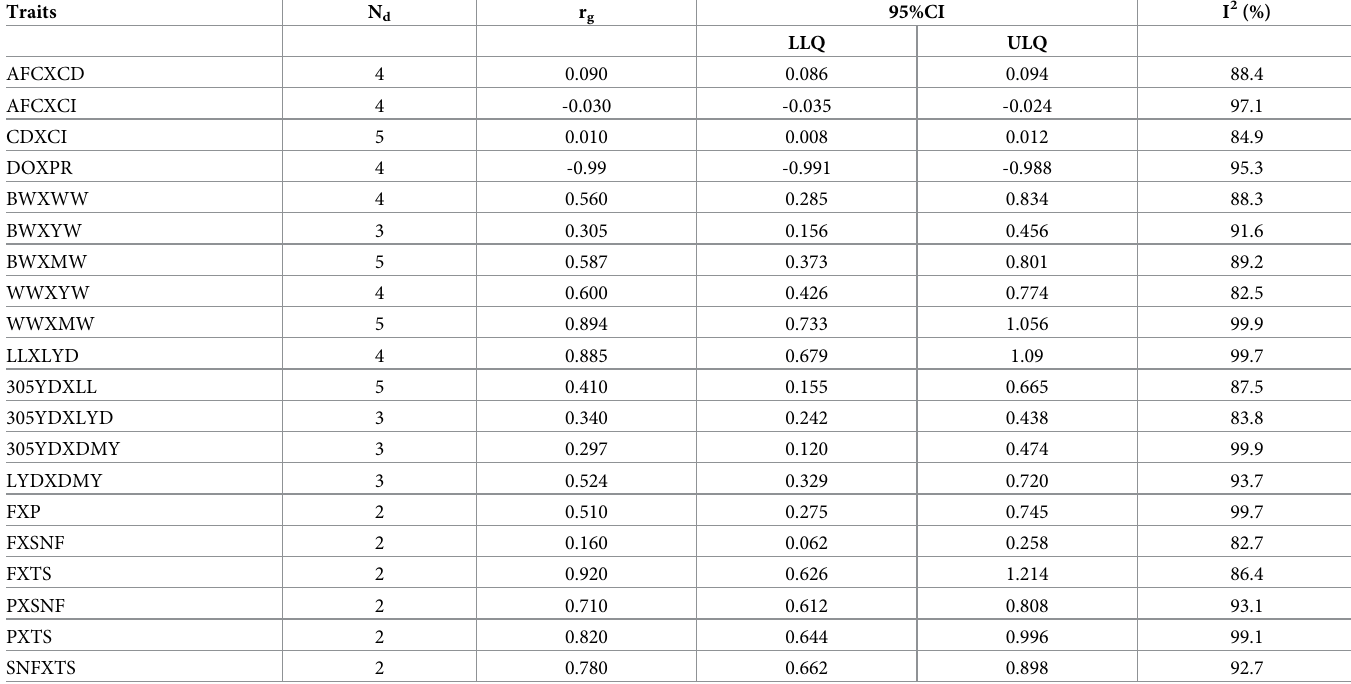
Table 7. Number of articles (N d ), genetic correlation among traits(g r ) estimated from meta-analysis using random model, 95% confidence interval (95% CI), and the values of I 2 index(I 2 ) in each trait.